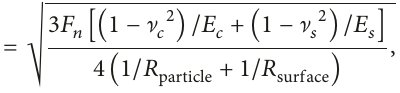
caused a higher total contact pressure than the smooth one in the penetrating process. As can be seen in Figure 7 this effect is mainly due to the increase of local surface curvature giving rise by the convex unit which is changed from 1/𝑅 smooth to 1/𝑅 convex . According to (4) found by Hertz theory, higher curvature gives smaller contact radius a and finally causes higher contact stress that is calculated by 𝐹 𝑛 /𝑎